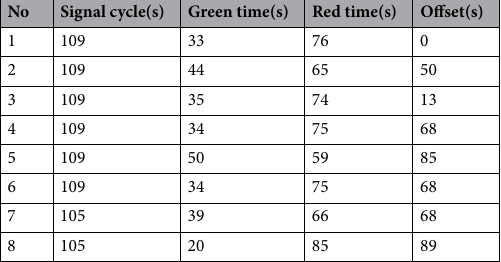
Table 5. Signal timing data at signalized junctions.